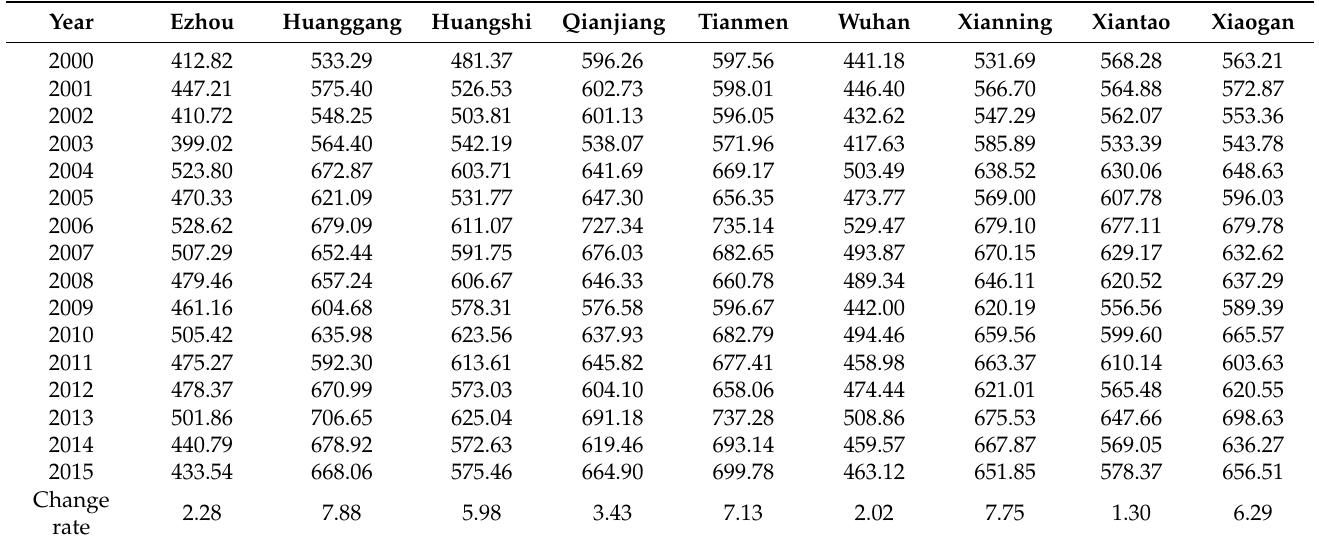
Figure 2. Temporal variation of annual NPP (gC × m − 2 ) for the whole Wuhan City Circle area from 2000 to 2015. Note: The red line indicates the linear fitting for the period of 2000 to 2015. The p value documents the significance. Error bars extending from the means document the standard deviation of Annual NPP, while the light red region represents the 95% confidence intervals of the linear model. Table 4. Temporal variations of annual NPP (gC × m − 2 ) for nine cities in Wuhan City Circle from 2000 to